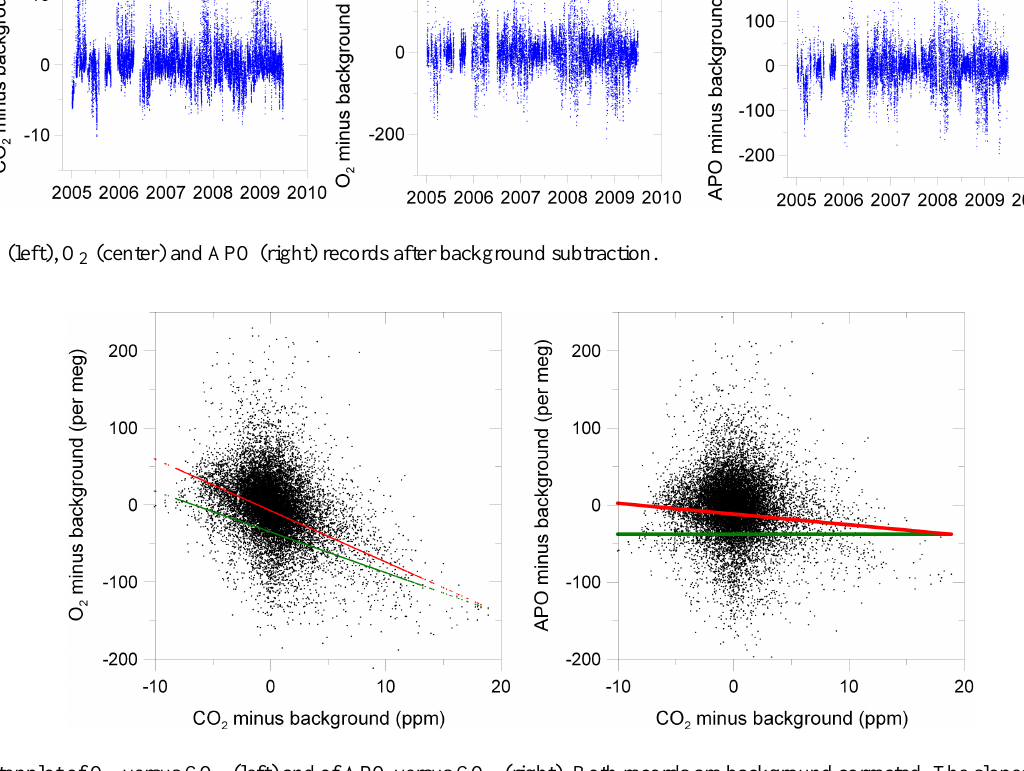
Fig. 6. Scatter plot of O 2 versus CO 2 (left) and of APO versus CO 2 (right). Both records are background corrected. The slopes of fossil fuel burning ( − 1 . 4molmol − 1 , red line) and of land photosynthesis and respiration ( − 1 . 1molmol − 1 , green line) are overlaid for reference. APO is invariant with respect to land biospheric processes by its definition (green line, right